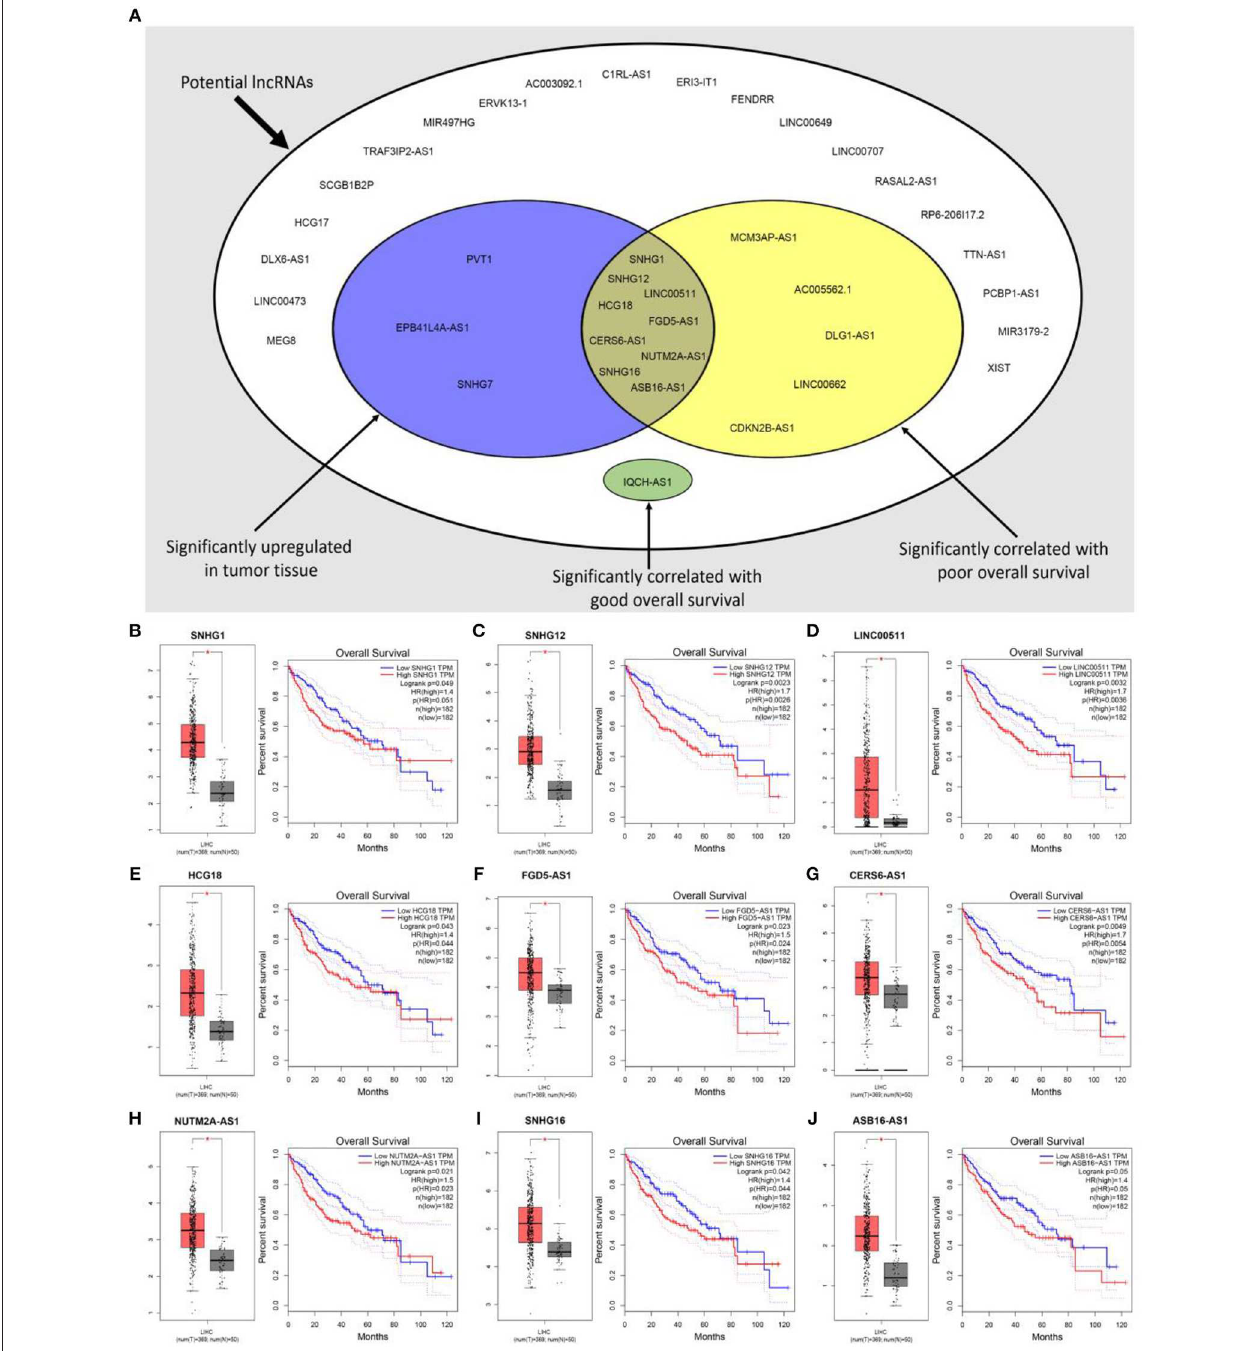
FIGURE 7 | Expression analysis and survival analysis of potential lncRNAs in hepatocellular carcinoma. (A) SNHG1, SNHG12, LINC00511, HCG18, FGD5-AS1, CERS6-AS1, NUTM2A-AS1, SNHG16, and ASB16-AS1 were identified as key lncRNAs in hepatocellular carcinoma by combination of their expression levels and prognostic values; (B) SNHG1 was significantly upregulated in tumor tissues and linked to poor prognosis of hepatocellular carcinoma; (C) SNHG12 was significantly upregulated in tumor tissues and linked to poor prognosis of hepatocellular carcinoma; (D) LINC00511 was significantly upregulated in tumor tissues and linked to poor prognosis of hepatocellular carcinoma; (E) HCG18 was significantly upregulated in tumor tissues and linked to poor prognosis of hepatocellular carcinoma; (F) FGD5-AS1 was significantly upregulated in tumor tissues and linked to poor prognosis of hepatocellular carcinoma; (G) CERS6-AS1 was significantly upregulated in tumor tissues and linked to poor prognosis of hepatocellular carcinoma; (H) NUTM2A-AS1 was significantly upregulated in tumor tissues and linked to poor prognosis of hepatocellular carcinoma; (I) SNHG16 was significantly upregulated in tumor tissues and linked to poor prognosis of hepatocellular carcinoma; (J) ASB16-AS1 was significantly upregulated in tumor tissues and linked to poor prognosis of hepatocellular carcinoma. * P < 0.05.